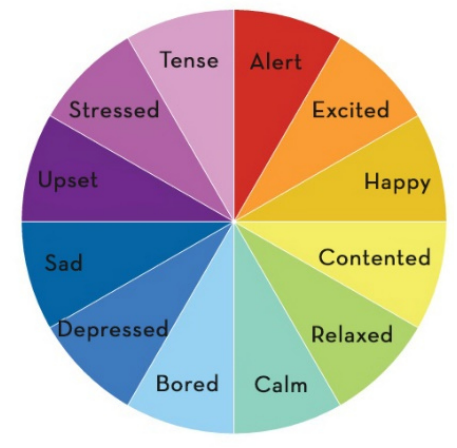
Figure 2 - Circum plex model with the colours used for the